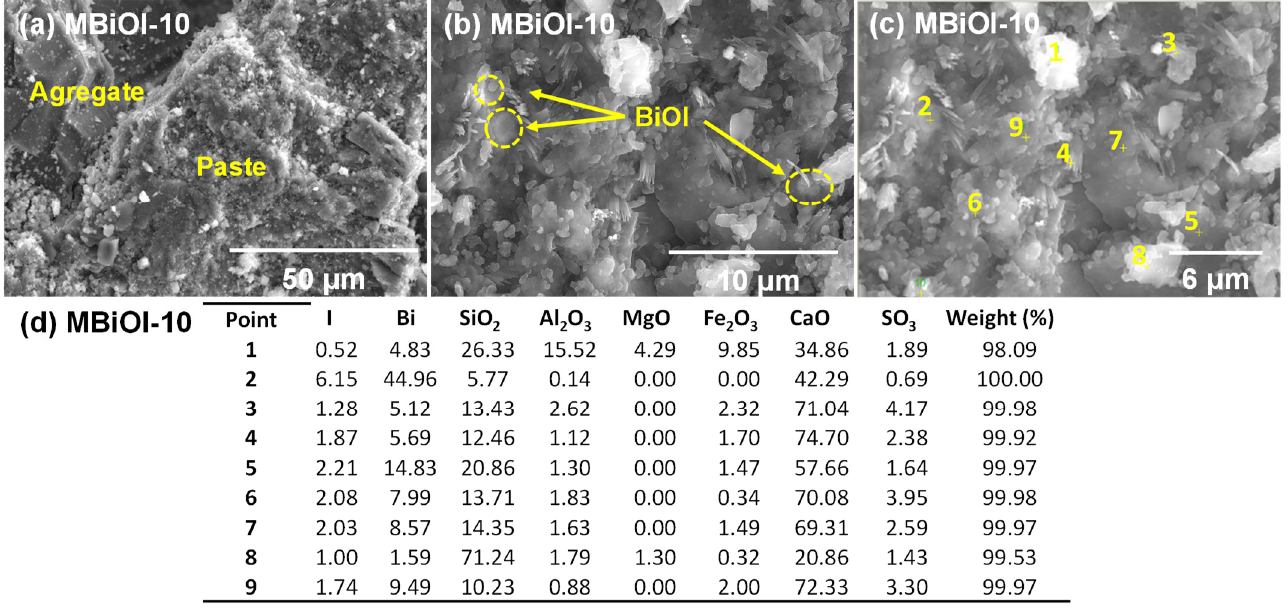
Figure 7. SEM images ( a – c ) and EDS microanalysis ( d ) of MBIOI-10 mortar at 28 days.